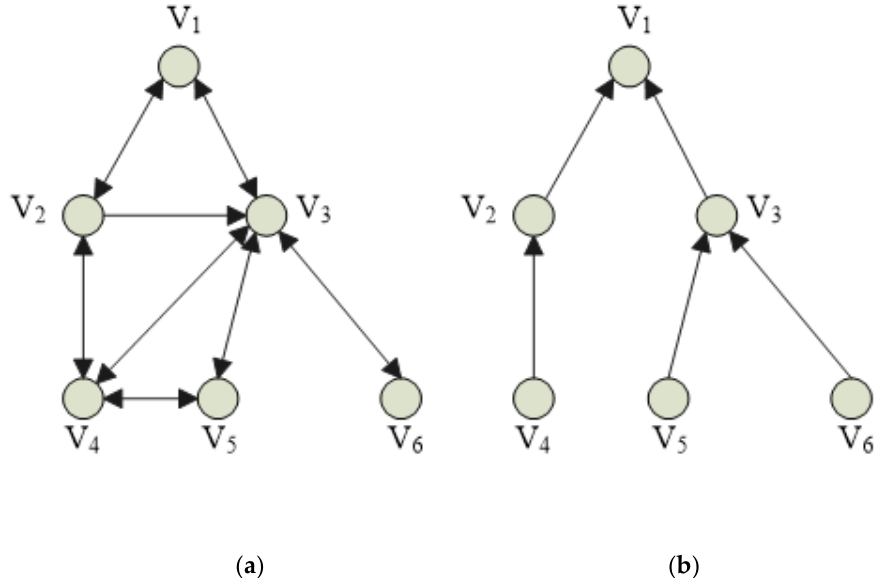
Figure 2. Example of building a routing tree. ( a ) Undirected graph ( ) , G V E = , ( b ) Routing tree ( ) , t T V E = .